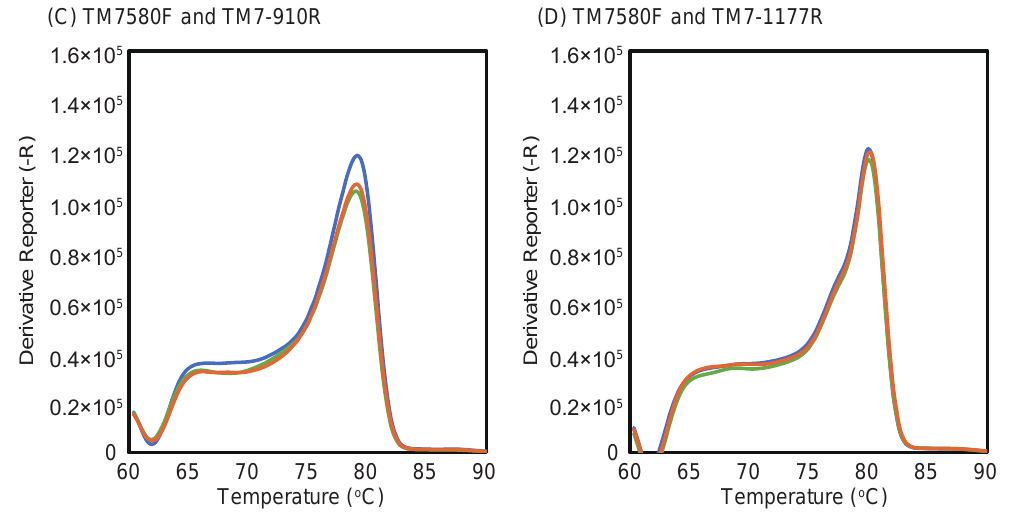
Figure 4. Melting curves of qPCR reactions using activated sludge samples and the four primer sets: TM7314F and TM7-910R ( A ); TM7314F and TM7-1177R ( B ); TM7580F and TM7-910R ( C ); and TM7580F and TM7-1177R ( D ).